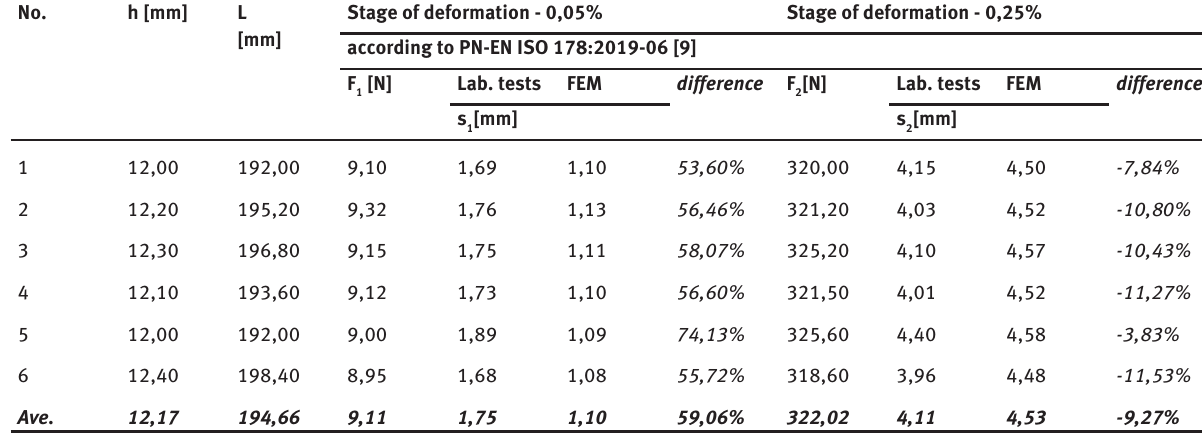
Table 11: Comparison of results of numerical analyses and laboratory tests for a model of a liner with a diameter of 500mm and 12,00mm wall